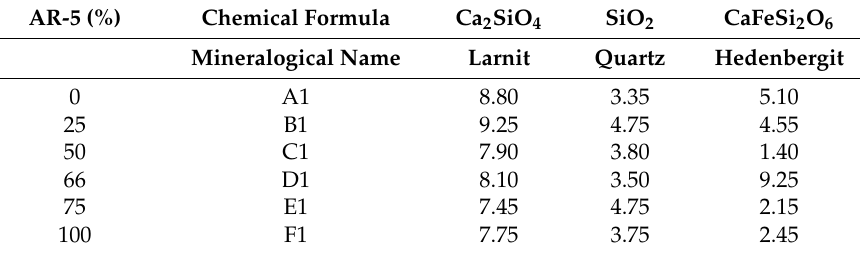
Table 9. Phase composition of